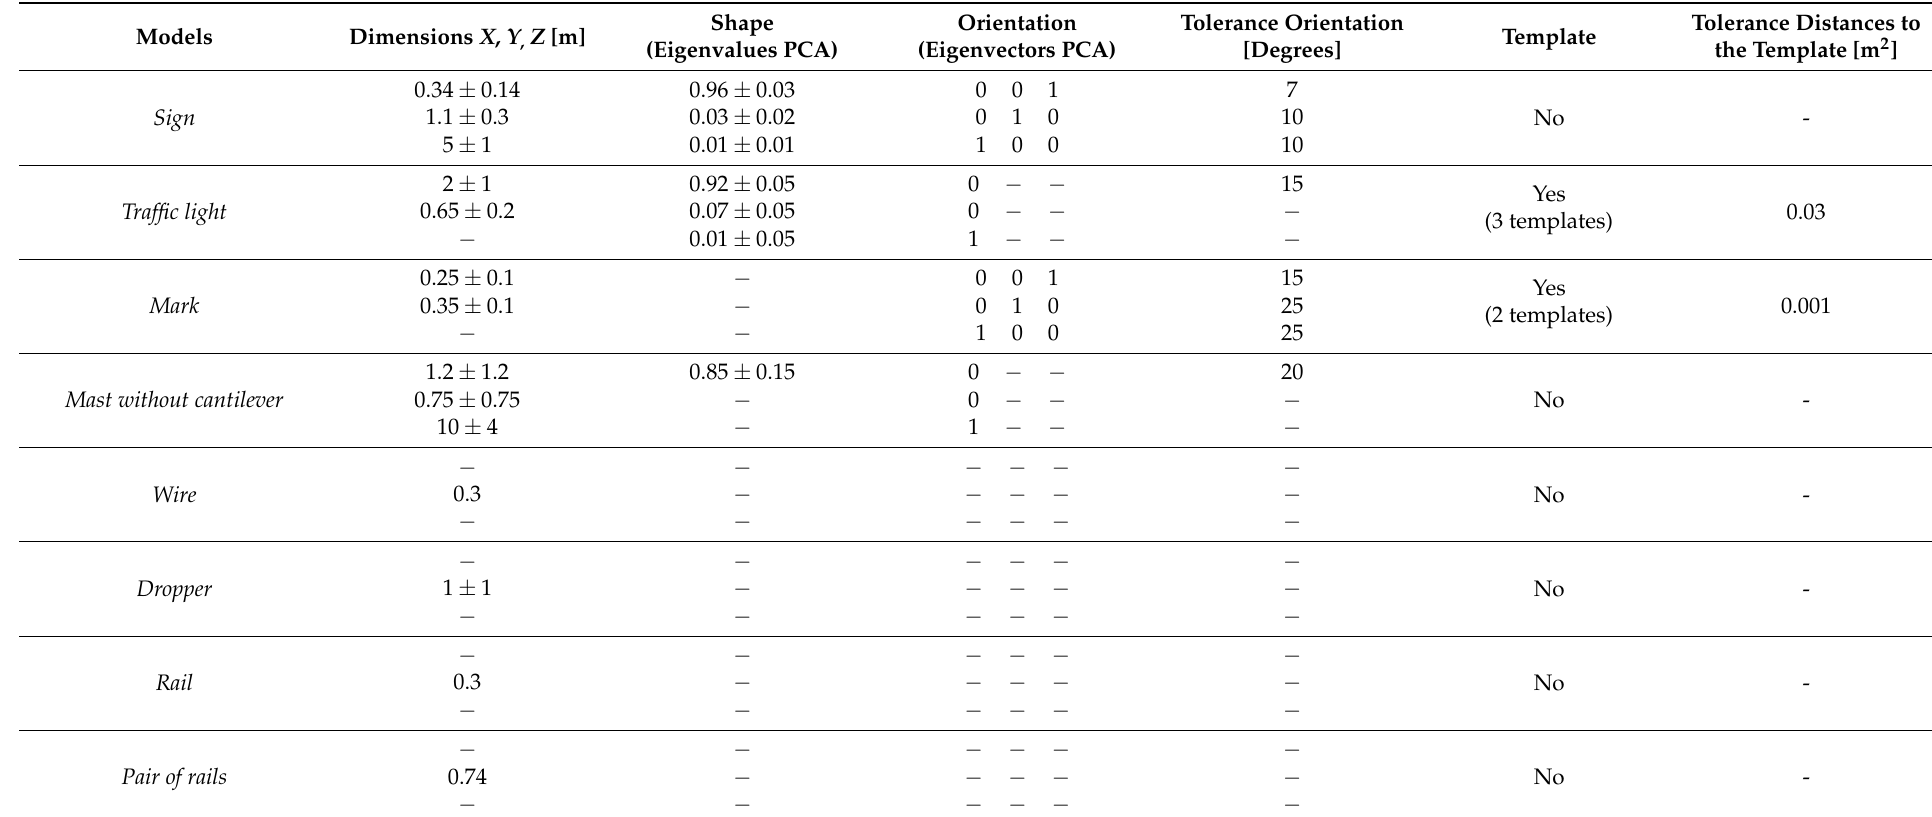
Table 1. Models used in the segmentation process to define the parameters of the algorithms and to analyse clusters of points comparing them with the specifications of each model. The dimensions of the models are defined in X , Y , Z . Their shapes are defined by the eigenvalues obtained applying PCA. Their orientation is defined by the eigenvectors obtained applying PCA, represented in a 3 × 3 matrix, being sorted by columns. The deviation to those eigenvectors is defined in degrees. The template is a set of points formed by the points of a given element manually extracted from the data and the distance to that template is calculated with Equation